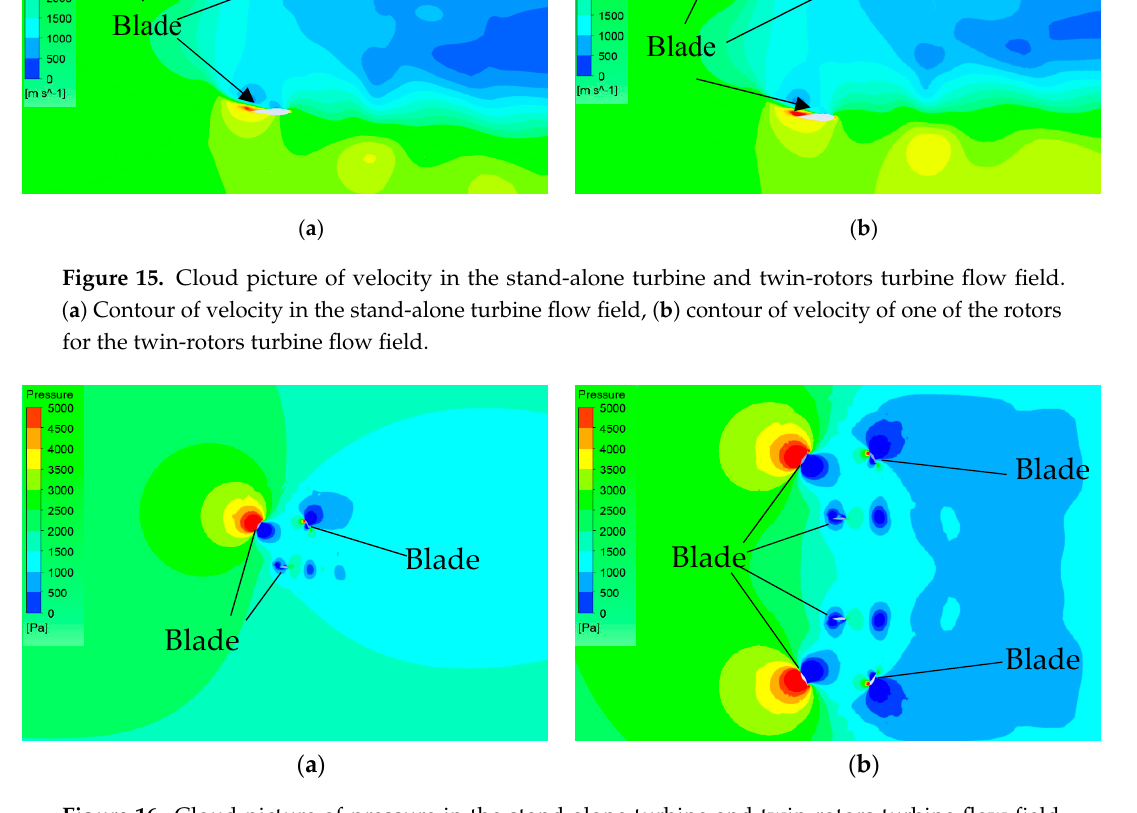
Figure 16. Cloud picture of pressure in the stand-alone turbine and twin-rotors turbine flow field. ( a ) Contour of pressure in the stand-alone turbine flow field, ( b ) contour of pressure in the twin-rotors turbine flow field.